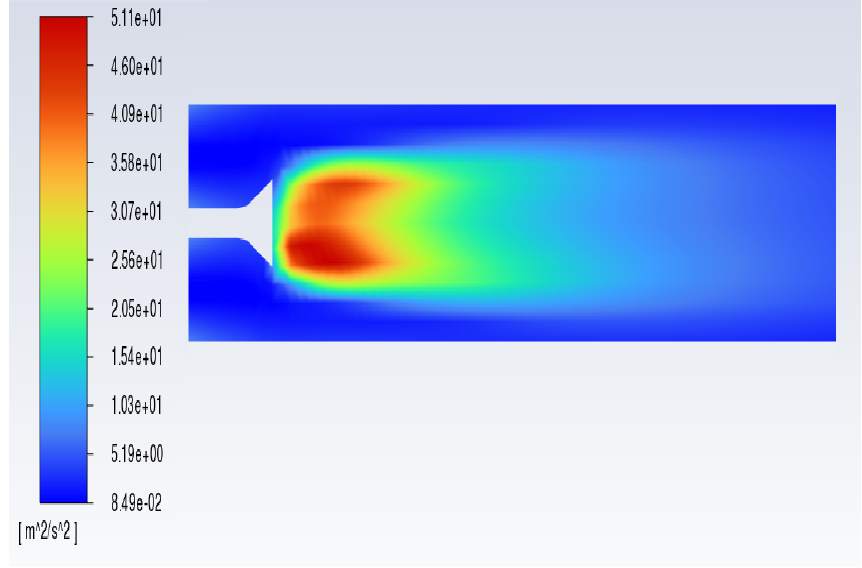
Figure 3. The contours of the computed mean turbulent kinetic